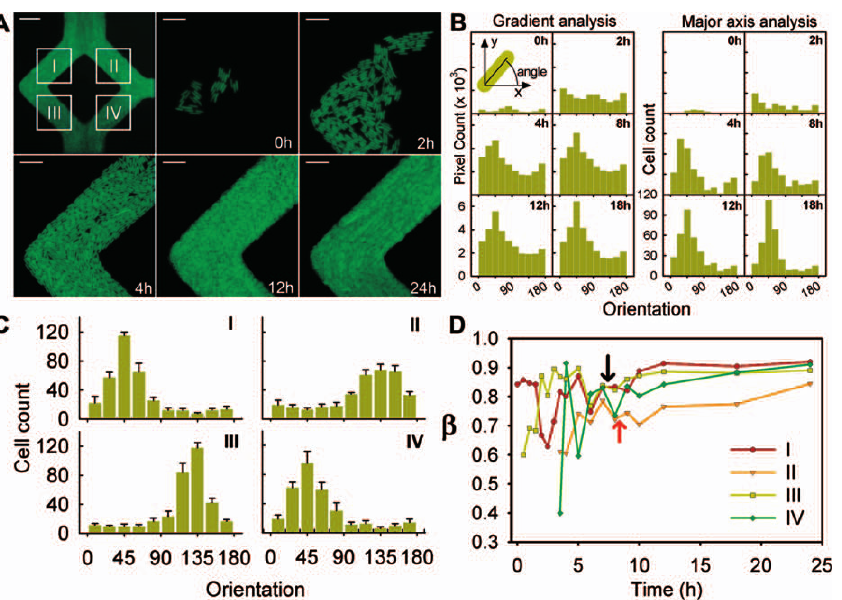
Figure 2. Self-Organization of an E. coli Colony in an RIR Chamber (A) Representative time-lapse epi-fluorescence images of an E. coli colony expressing GFP under the LuxR- lux box control. The fluorescence intensity was adjusted for visualizing the colony at single-cell resolution. The first sub-panel is a large-scale view of the RIR chamber, and the other sub-panels show the left ‘‘ elbow ’’ region of the chamber at different time points (0,2,4,12,24h). Scale bars: 30 l m, the 1st sub-panel; 10 l m, all other sub-panels. See also Video S1–S3 (B) Comparison between the gradient and major axis analyses of cell orientation. Histograms of cell orientations in region I in (A) resulting from each analysis are shown for indicated time points. The range of the x -axis is in degrees in all histograms in this and other Figures. (C) The steady-state orientation histograms for cells in regions I–IV. The frequency within each bin is averaged over five time points between 19 and 24 h. Values are expressed as means 6 standard deviation. (D) Time-dependence of the fraction, b , of cell population oriented within 45 8 of the preferred cell orientation in selected regions. The preferred cell orientations were estimated based on the steady state orientation distributions: I- 45 8 ; II- 135 8 ; III- 135 8 ; IV- 45 8 with respect to the x -axis. The arrows indicate when the colony becomes densely packed (black: I–III; red: IV).